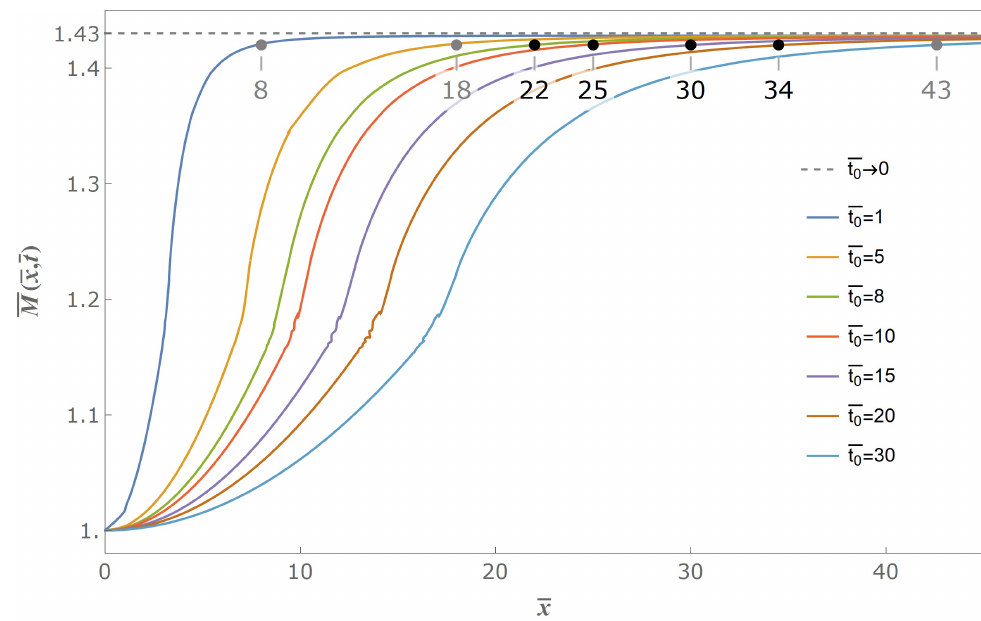
Figure 10. Envelope schematic of maximum excited bending moment with different t 0